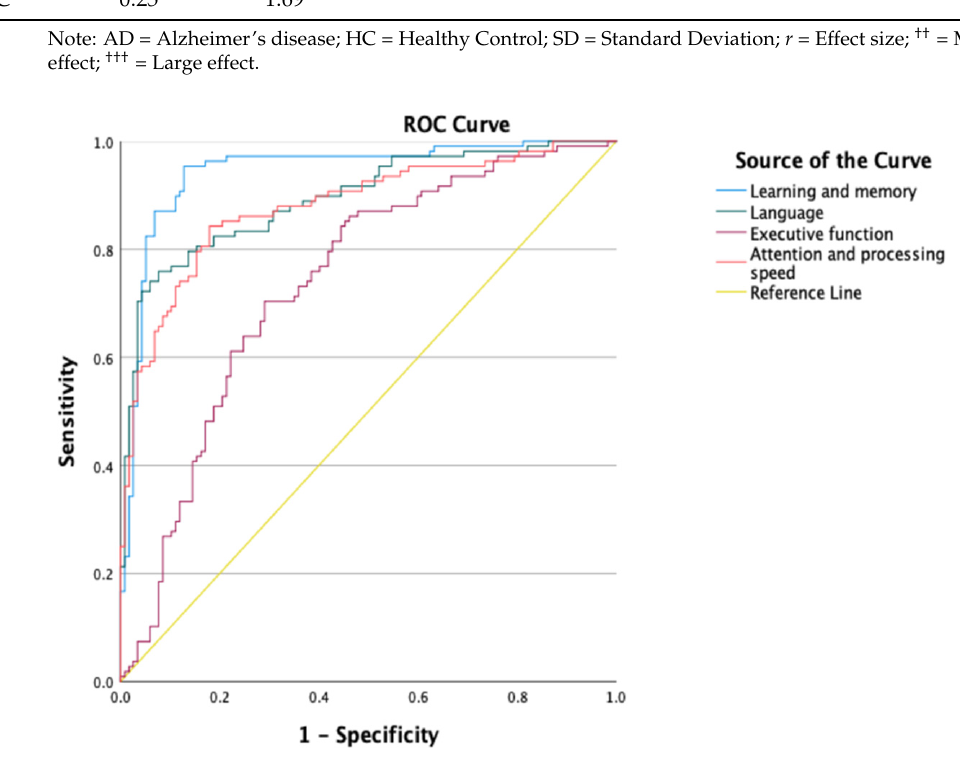
Table 5. Average performance between groups by cognitive domain.